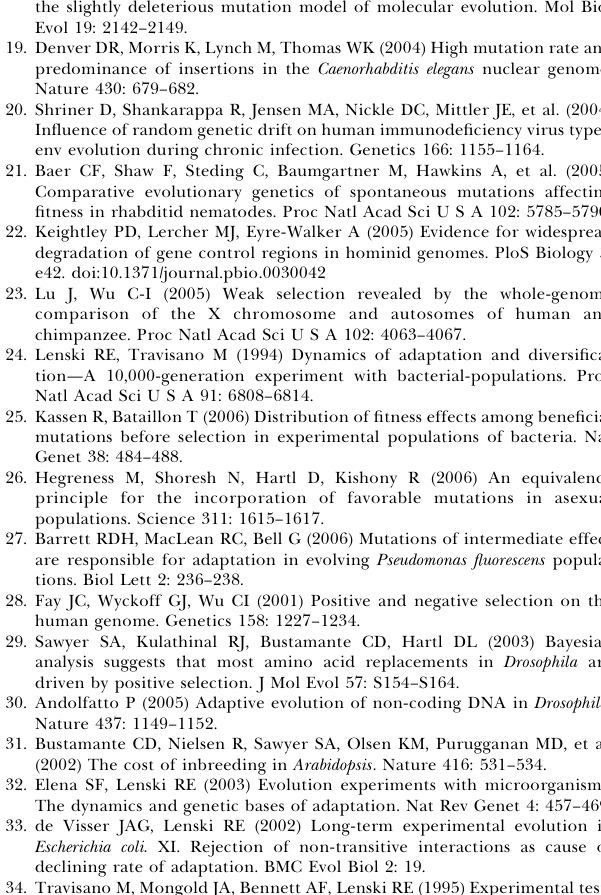
Figure S1. Confidence Limits for the Parameters of the Mutational Distributions in Low- and High-Fitness Clones When B Is Held Constant (A) Confidence limits for the ML parameter values of the gamma distribution in the low-fitness clones. The proportion of beneficial mutations, B, was left at its ML value of 0.16. The joint likelihood surface for the three MA analyses in the low-fitness lines is shown. (B) Confidence limits for the ML parameter values of the gamma distribution in the high-fitness lines. The proportion of beneficial mutations, B, was left at its ML value of zero. (C) Confidence limits for the ML parameter values of the gamma distribution in all MA lines. The proportion of beneficial mutations, B, was left at its ML value (0.16 or 0). The joint log-likelihood value is indicated to the right of each panel; the ellipses indicate the 50%, 80%, 90%, and 95% confidence limits. The y -axis shows the estimated mean of the distribution, while the x -axis is the coefficient of variation (1/ = b ). The estimated mean of the distribution is relatively constant for the two groups, providing little support for any hypothesis under which the mean value of the selection coefficient changes with fitness. However, there is less confidence in the shape of the distribution (beta). Figure S2. Confidence Limits for the Parameters of the Mutational Distributions in Low- and High-Fitness Clones When Beta Is Held Constant (A) Confidence limits for the ML parameter values of the gamma distribution in the low-fitness clones. The value of beta was kept constant, at